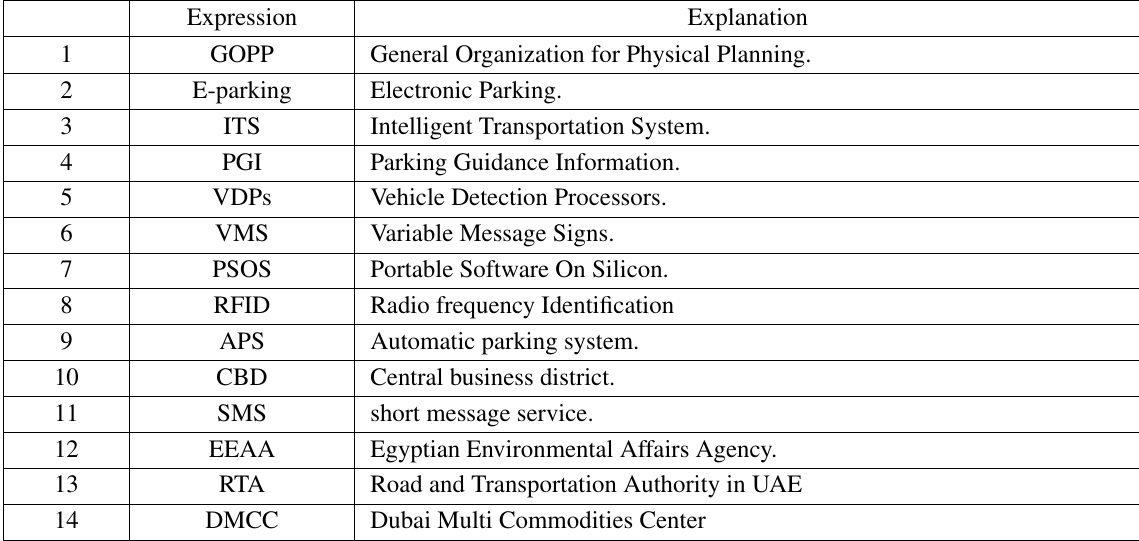
Table 9. Terminologies (Source: